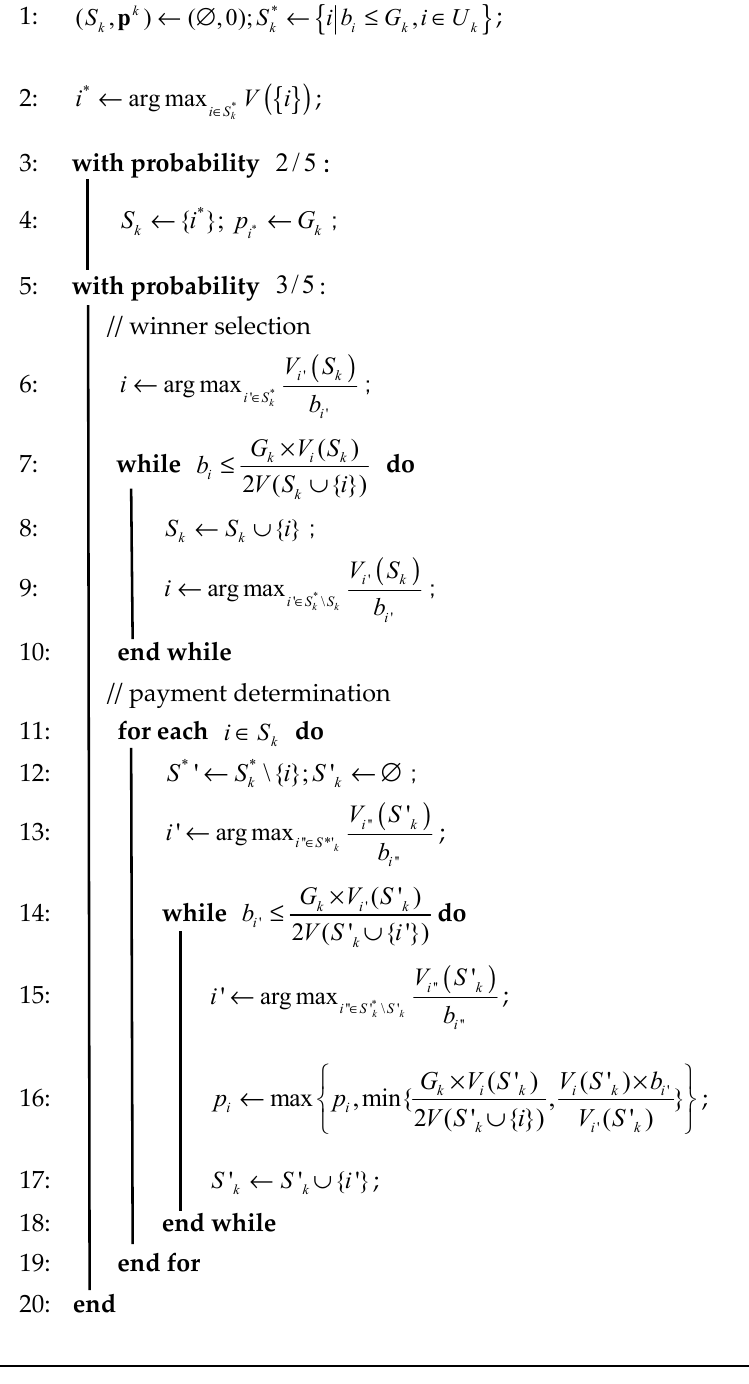
Algorithm 2: Budget Feasible Reverse Auction